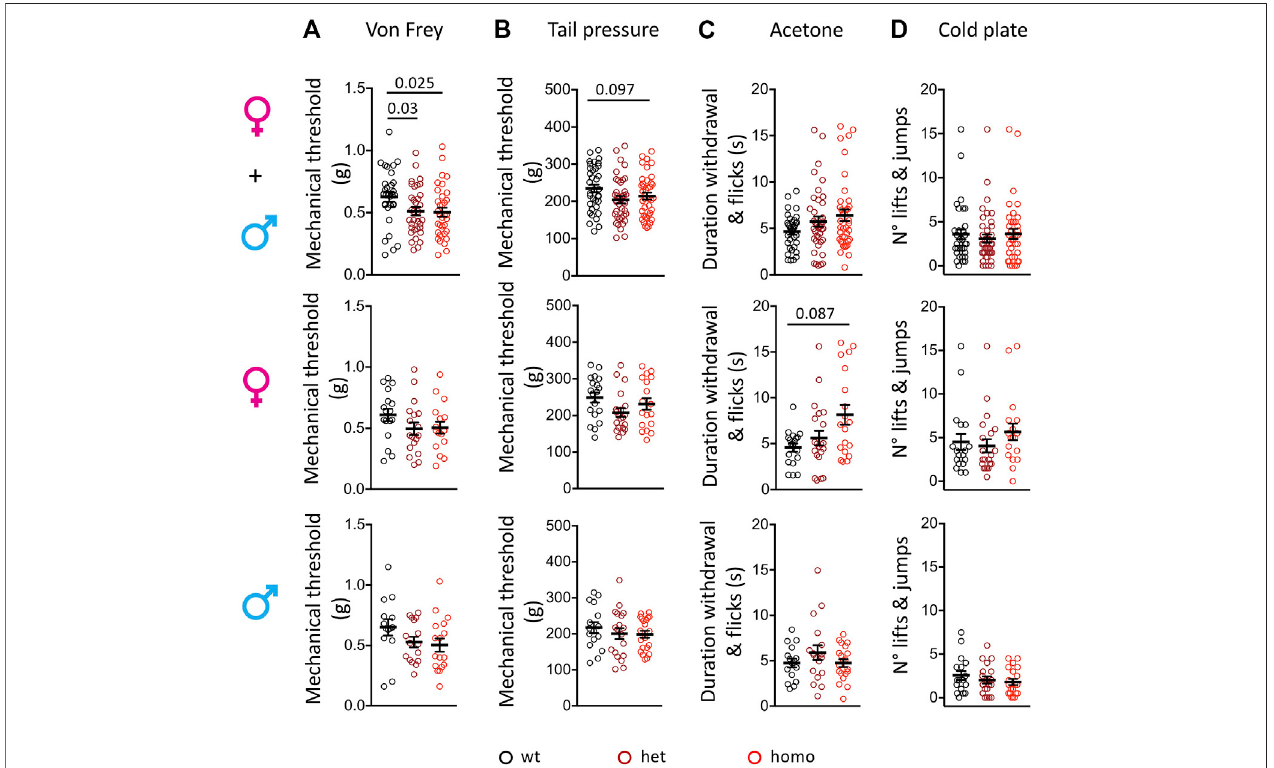
FIGURE 3 | Scn10a G1663S mice show enhanced pain sensitivity to mechanical and cool stimuli. (A) G1663S mutant mice displayed hypersensitivity to von Frey fi laments. Females, n (cid:1) 17 – 18/group; males n (cid:1) 14 – 17/group. The one-way ANOVA showed a general genotype effect in sex-grouped animals. Unpaired two-tailed t-tests showed a genotype effect for wt vs. heterozygous and wt vs. homozygous mutant sex-grouped mice. The 2 bars and p values are for genotype difference in grouped females and males, wt vs. heterozygous and wt vs. homozygous mutants. (B) Noxious mechanical sensitivity was analyzed by the tail pressure test. Females n (cid:1) 18 – 20/group; males n (cid:1) 16 – 20/group. Kruskal – Wallis analysis indicated a trend for genotype effect in sex-grouped animals. The bar and p value represent the overall genotype effect in grouped females and males. (C) Sensitivity to cool temperature was analyzed by the acetone test. Females n (cid:1) 19 – 21/group; males n (cid:1) 16 – 20/group. Mutant females tended to display longer duration of paw reactions following acetone application. Kruskal – Wallis analysis. The bar and p value represent the overall genotype effect in females. (D) G1663S mutant mice showed no phenotype for cold response on the 5 ° C cold plate. Females n (cid:1) 18 – 21/group; males n (cid:1) 17 – 20/group.Kruskal – Wallisanalysisshowednogenotypeeffectineithersex-groupedorsexseparatedanimals.Dataareexpressedasmeans ± SEMinallpanels.See Supplementary Table S6 for detailed statistical